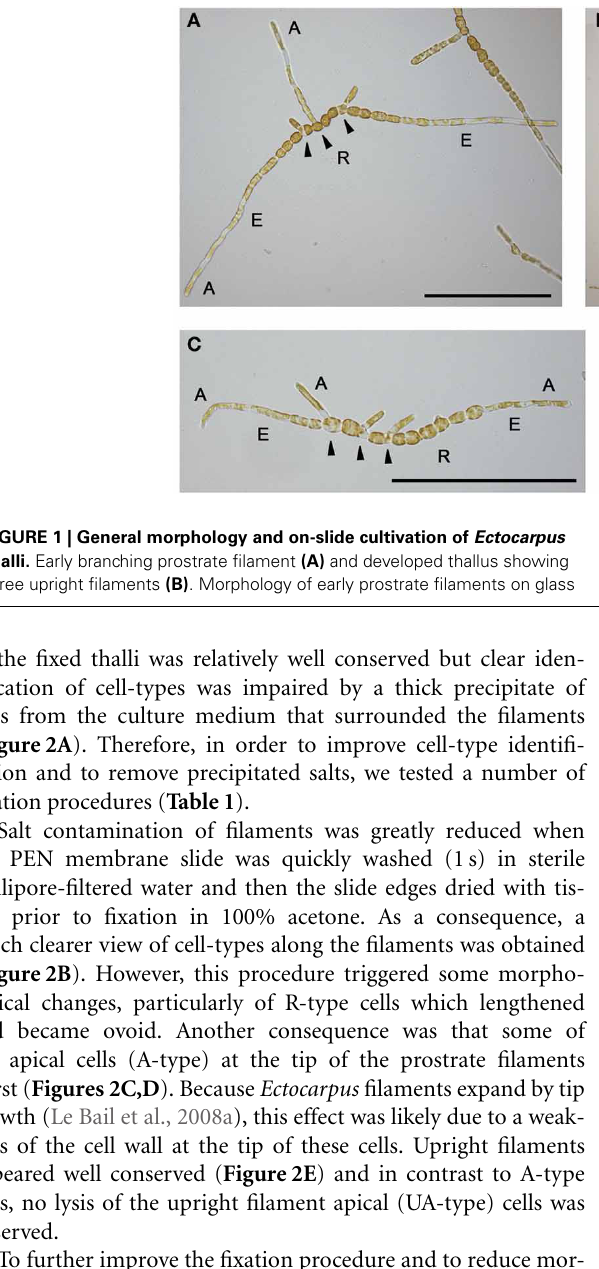
(C) and PEN membrane (D) slides. A, apical; E, elongated; R, round cells; Uf, upright filament. Arrows indicate branching cells within the prostrate filament. Scale bars equal to 200 μ m. (B) has been reconstructed from two